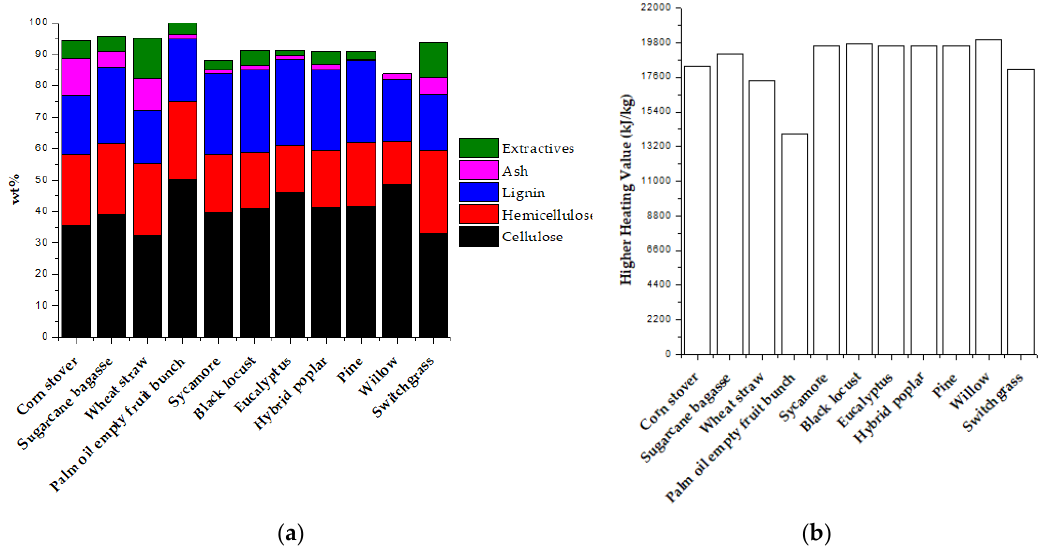
Figure 4. ( a ) Compositions of Biomass Expressed as a Percentage of Bone-Dry Material, and the ( b ) Higher Heating Value, adapted from [33,34].